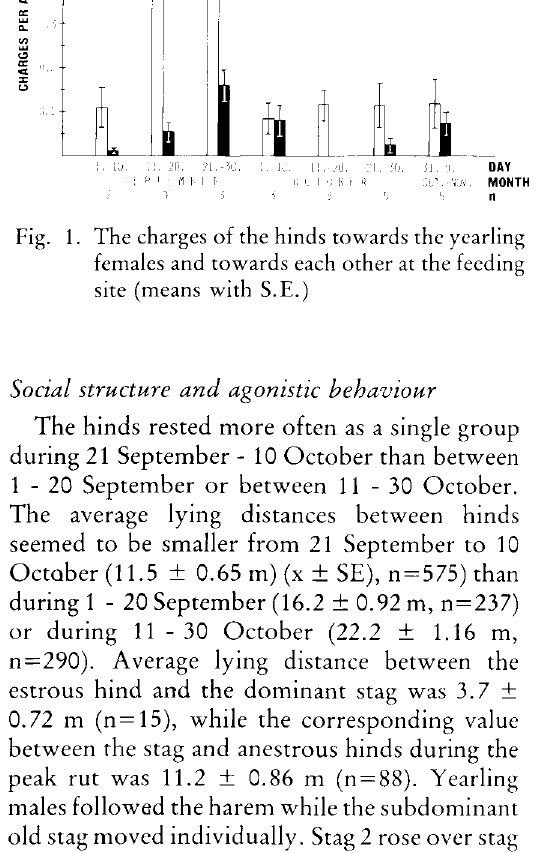
Fig. 1. The charges of the hinds towards the yearling females and towards each other at the feeding site (means with